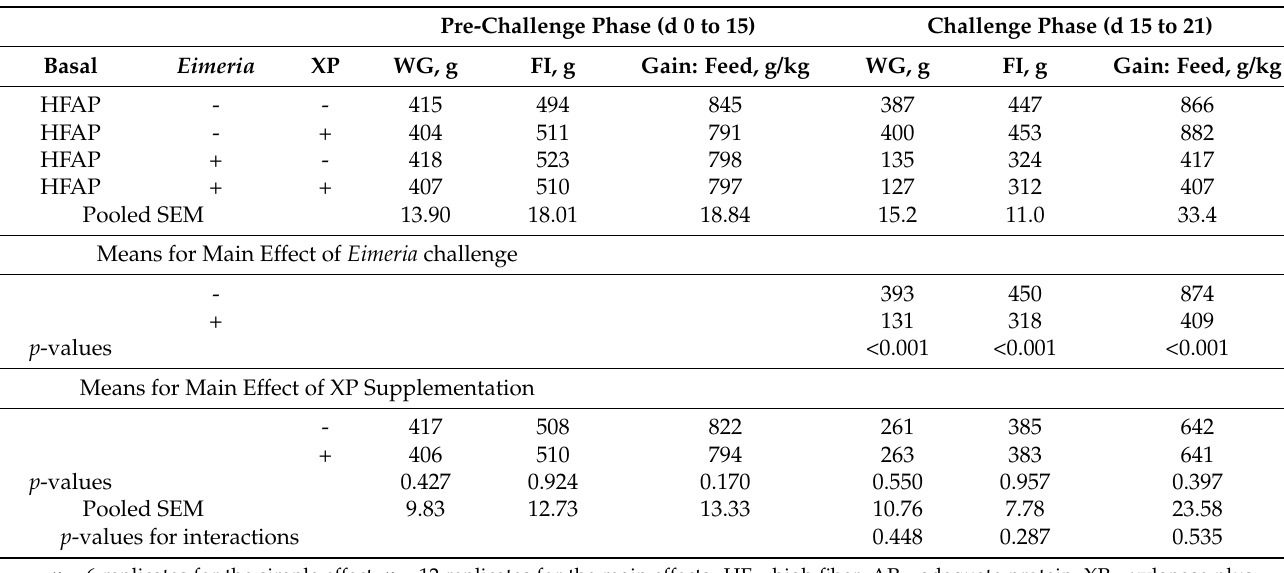
Table 4. Growth performance of the broiler chickens challenged or unchallenged with mixed Eimeria spp. in response to feeding diets with high fiber and adequate protein levels with or without enzymes supplementation (Expt. 1).